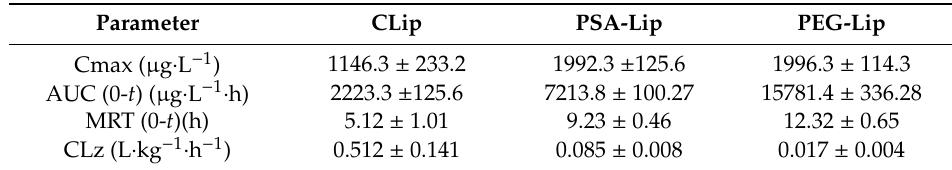
Figure 2. The blood clearance of various DiR labeled liposomes after intravenous administration in wistar rats at a dose of 5 µmol phospholipids/kg. Data were shown as mean ± S.D., n = 3. Table 4. Pharmacokinetic parameters of various DiR labeled liposomes after single intravenous administration in wistar rats ( n = 3).